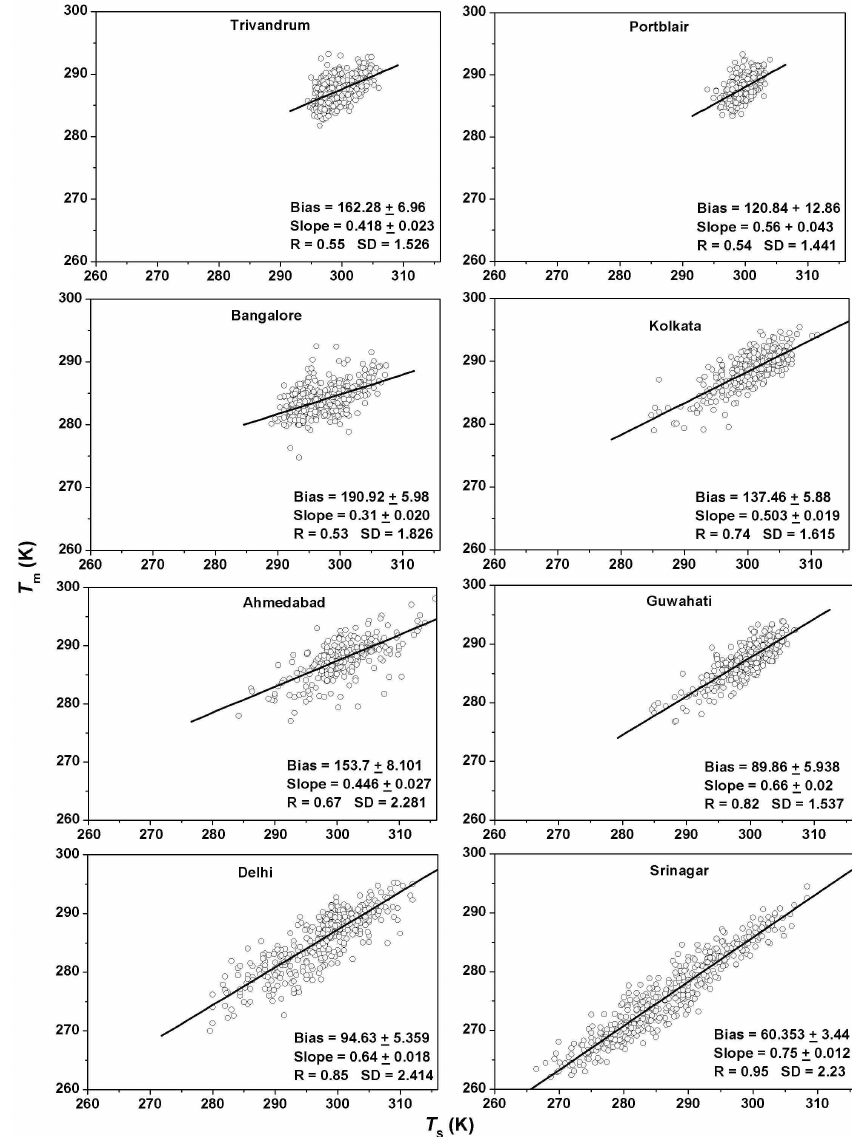
Fig. 5. Variation of T m with T s for the individual stations located at 8.5 ◦ N–32.6 ◦ N over Indian sub-continent based on upper air data for the period 1995–1997. the geographical locations of these stations are furnished in Table 1. The dynamical range of T m and T s and the correlation of T m with T s increase with increase in